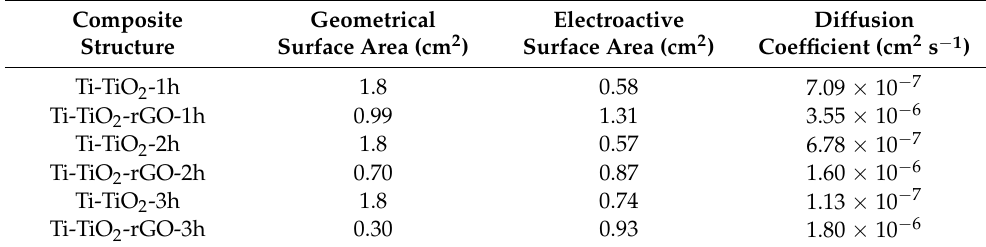
Figure 6. Cyclic voltammograms for the ( a ) Ti-TiO 2 -rGO-1h, ( c ) Ti-TiO 2 -rGO-2h, and ( e ) Ti-TiO 2 -rGO-3h composite structures, recorded in a 1M KNO 3 electrolyte support and ( b ) Ti-TiO 2 -rGO-1h, ( d ) Ti-TiO 2 -rGO-2h, ( f ) Ti-TiO 2 -rGO-3h composite structures in the presence of 4mM K 3 Fe(CN) 6 . Table 2. The apparent diffusion coefficient and electroactive surface area of the tested Ti-TiO 2 layers and the Ti-TiO 2 -rGO composite